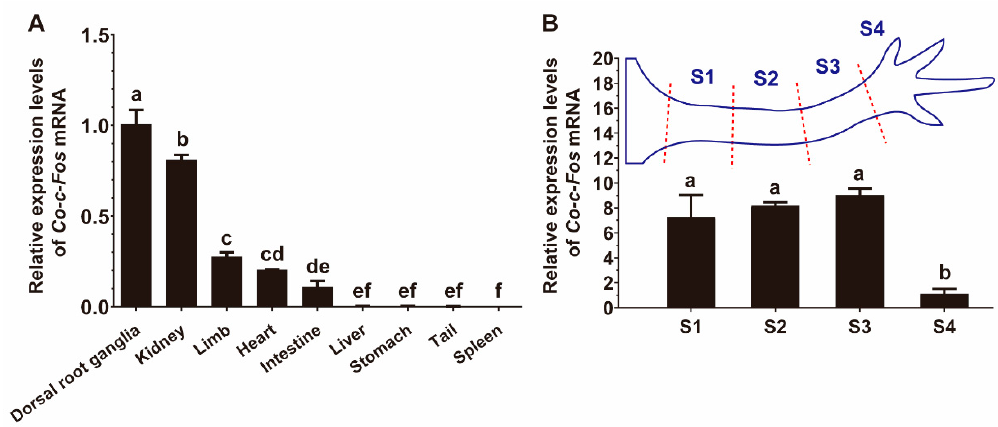
Figure 2. Tissue distribution of Co-c-Fos mRNA expression. ( A ) Relative mRNA expression levels of Co-c-Fos in various tissues of Cynops orientalis. The mRNA expression level of Co-c-Fos in dorsal root ganglia was set to one ( n = 3). ( B ) Relative mRNA expression levels of Co-c-Fos in the four limb segments as illustrated in a cartoon. The mRNA expression level of Co-c-Fos in the S4 segment was set to one ( n = 3). Data were analyzed using one-way ANOVA with Tukey test, and means with different letters indicated significant statistical difference ( p < 0.05).